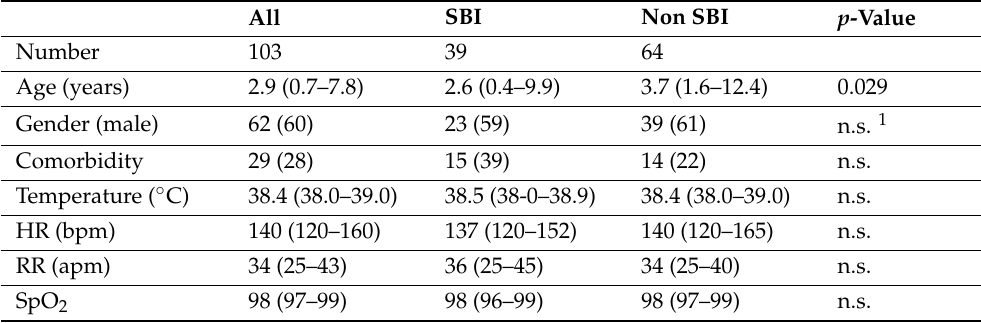
Table 2. Demographic and clinical characteristics of the population.